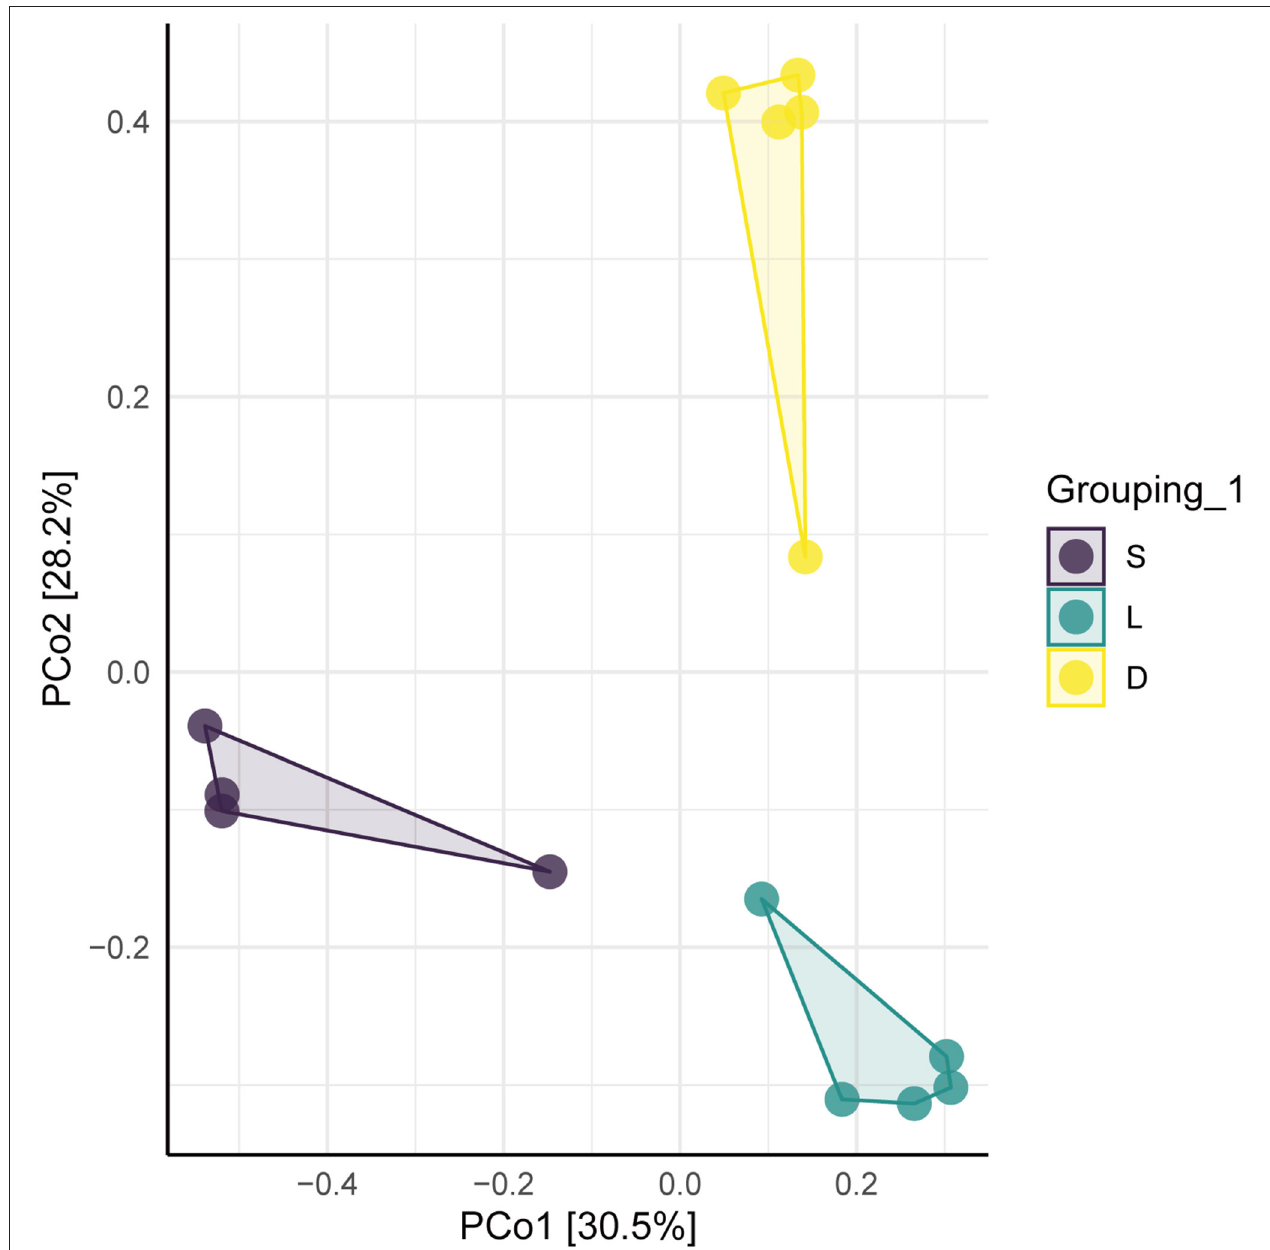
FIGURE 4 | Plot of PcoA of the dog gut microbial community. The three different groups were segregated into different community clusters.